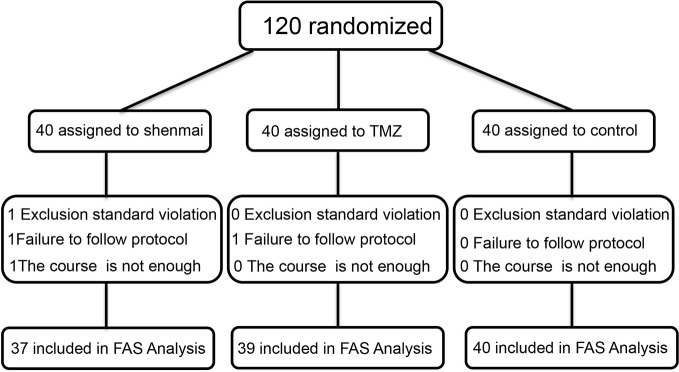
Flow chart of the patients included throughout the study. FAS, full analysis set.